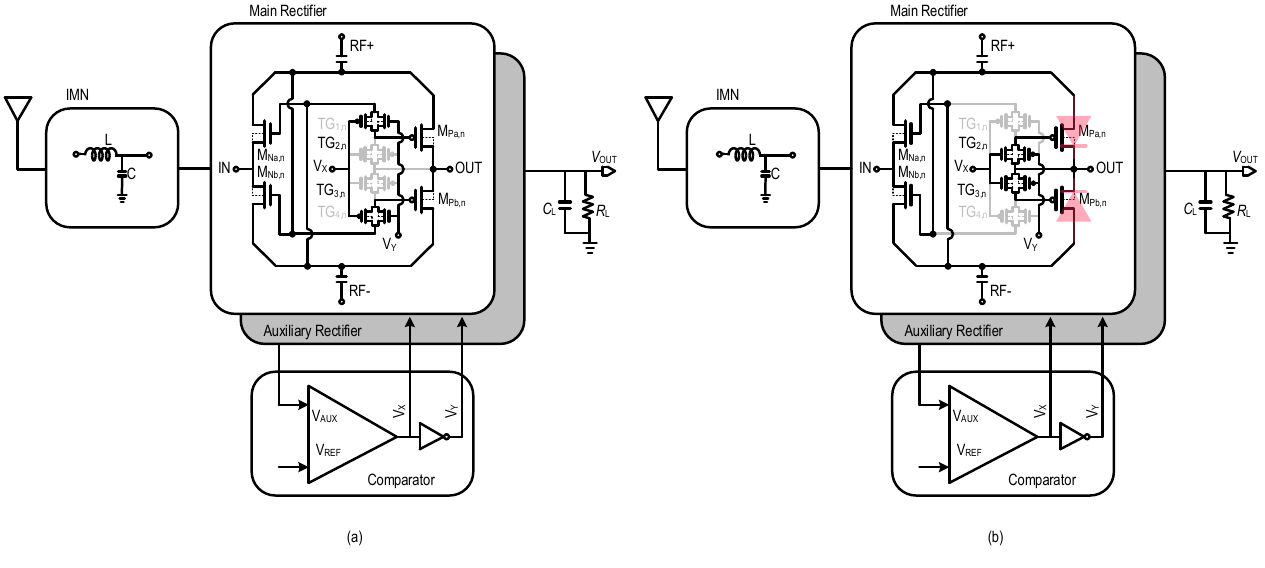
Figure 4. Top architecture of the proposed front-end RFEH: ( a ) at low input power, ( b ) at a high input power.